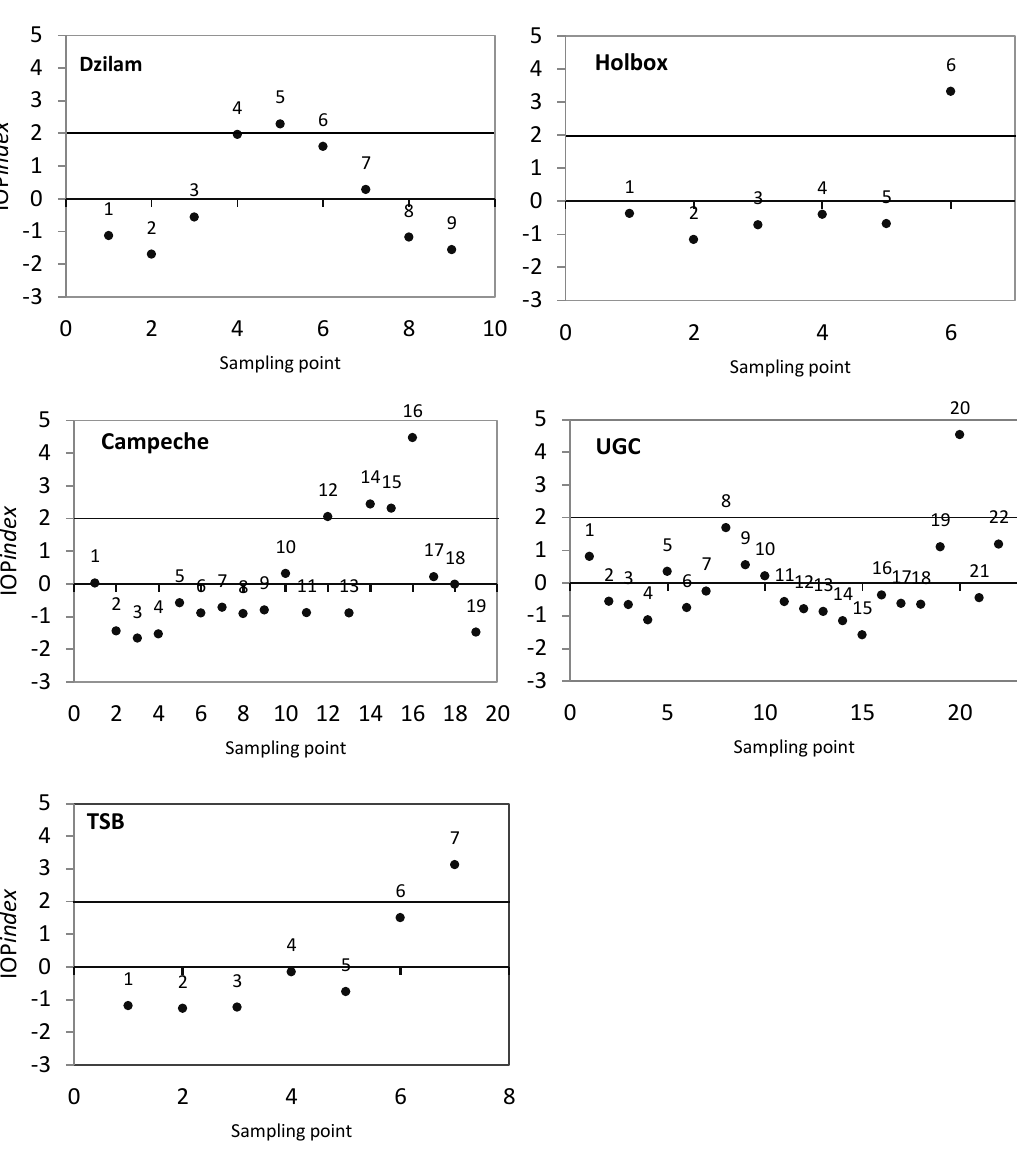
Figure 5. IOP index results for each sampling campaign and sampling point. From top to bottom and from left to right: Dzilam, Holbox, Campeche Bay, Upper Gulf of California (UGC) and Todos Santos Bay